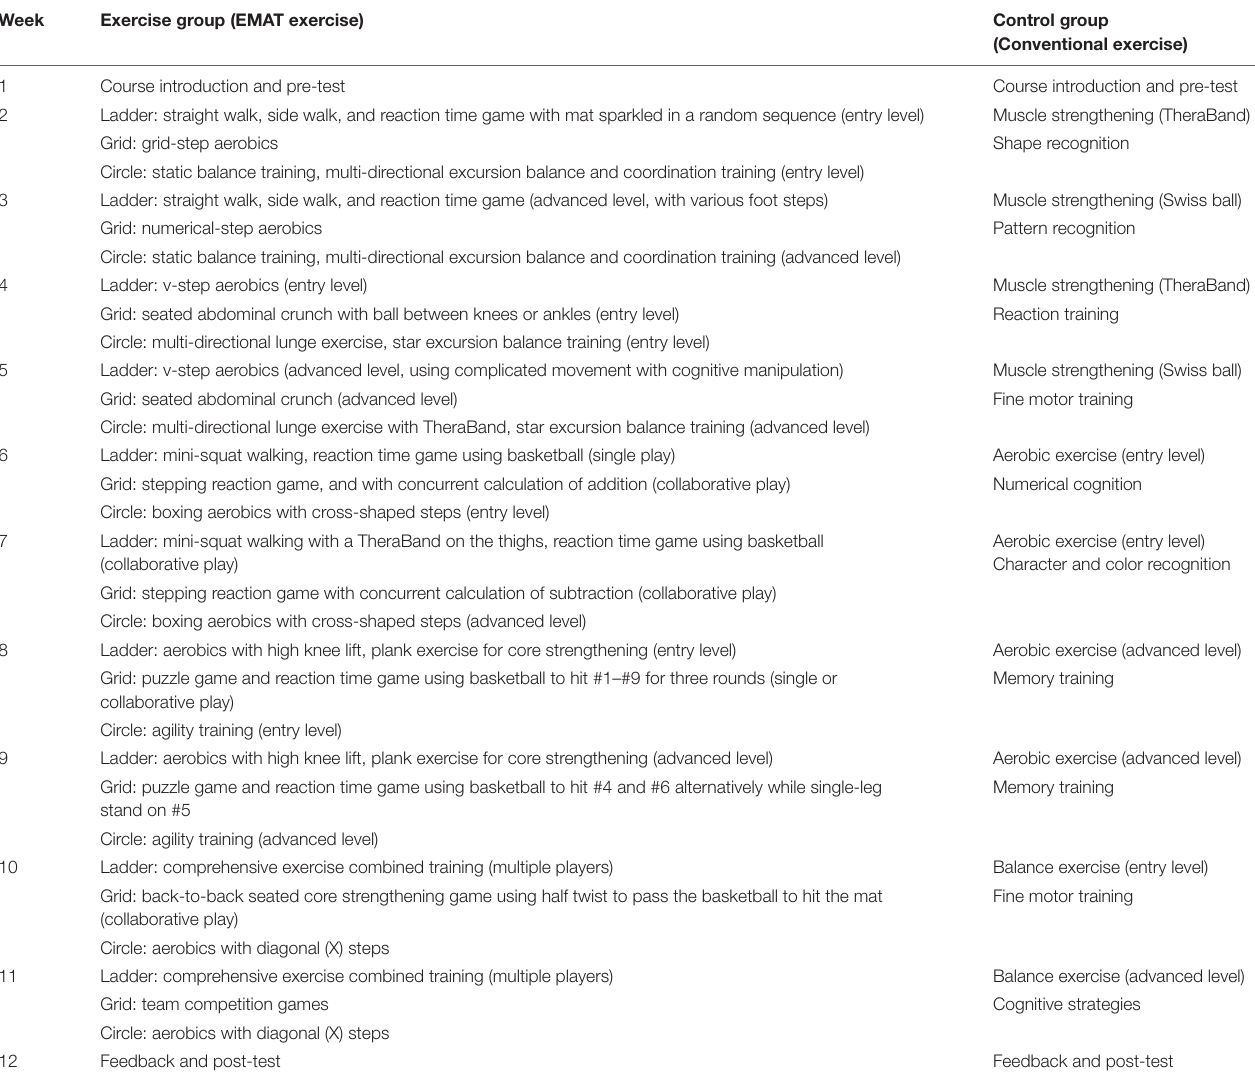
TABLE 1 | Multicomponent exercise intervention programs focusing on physical and cognitive training. Week Exercise group (EMAT